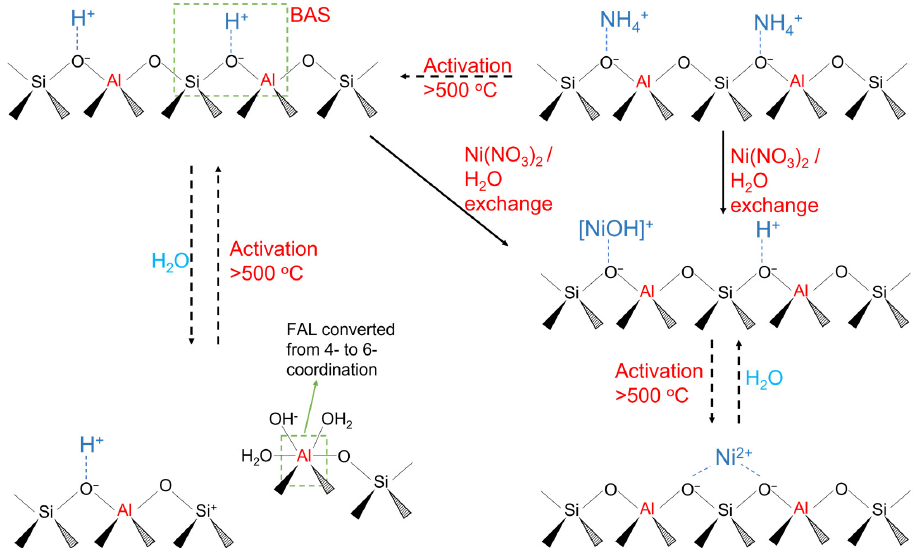
Figure 2. Scheme illustrating the parent cation-dependent aqueous ion-exchange chemistry of Ni 2+ species in zeolite Beta.